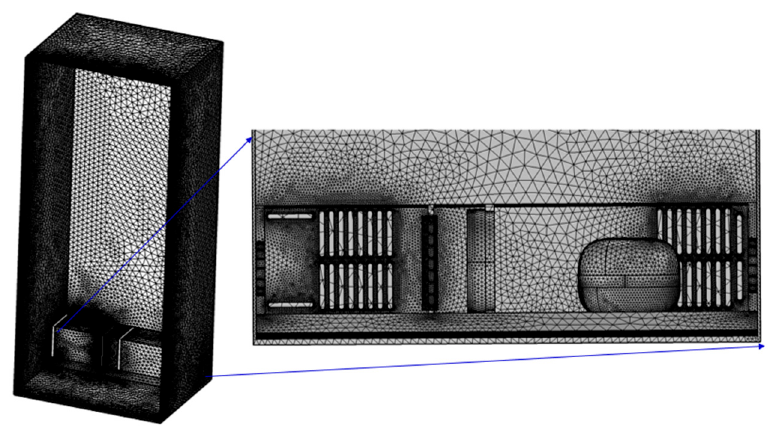
Figure 4. Mesh distribution of numerical model.